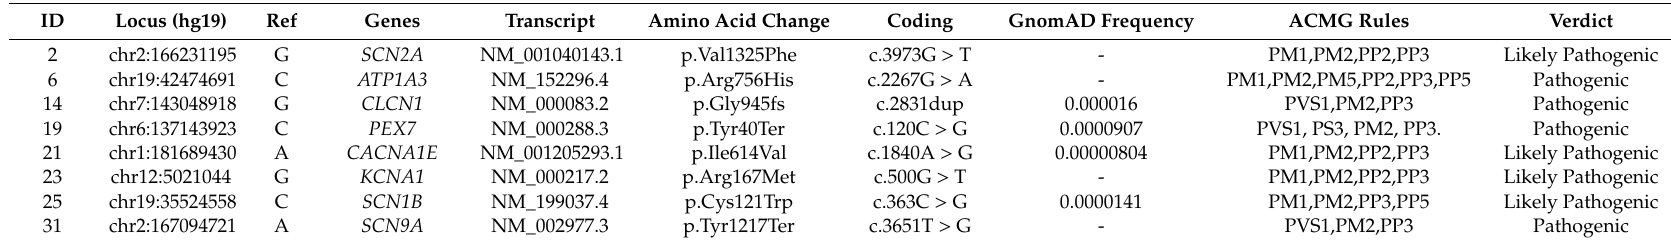
Table 2. Heterozygous mutations identified in episodic ataxia cases identified by whole exome